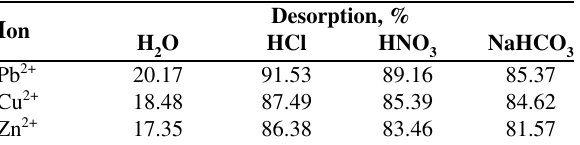
Table 8 . Desorption